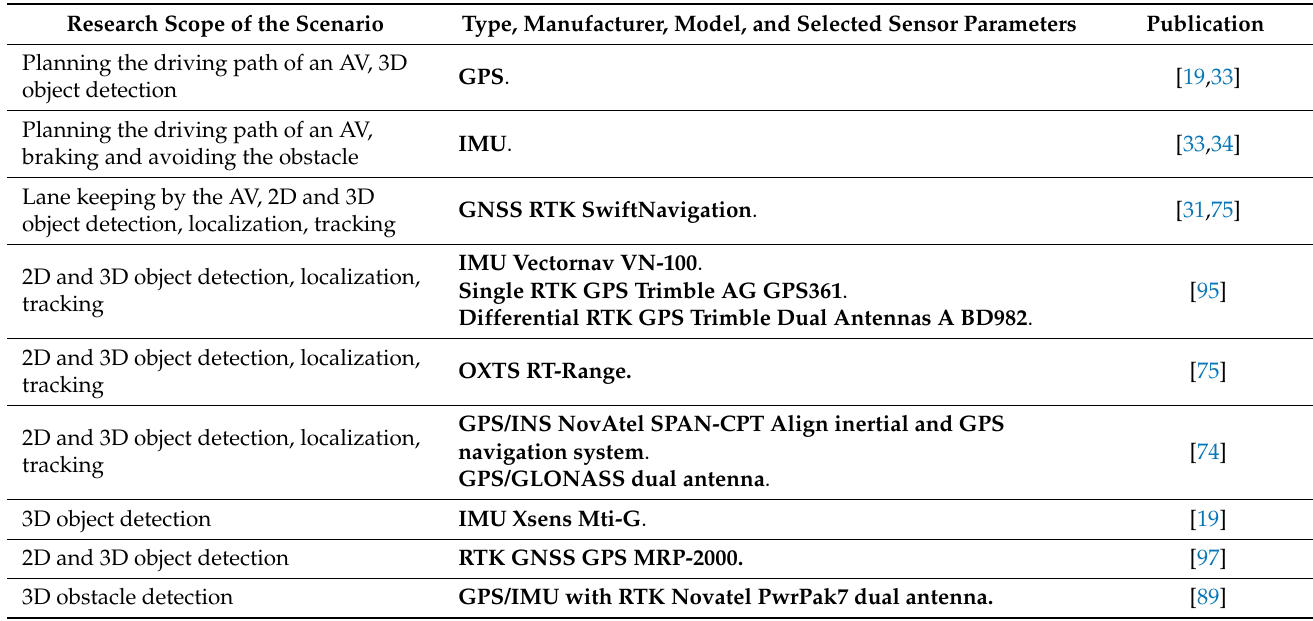
Table 10. Other sensors used in perception and control systems during AV